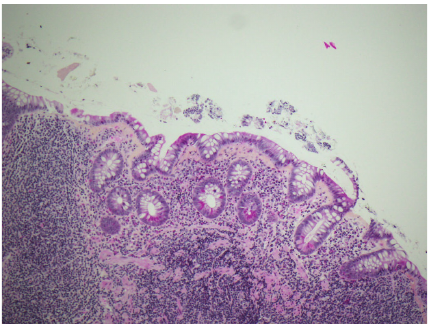
Figure 1: The ileal biopsies of the patient showed pathognomonic findings of collagenous sprue including villous atrophy with thick- ened collagen table (HPS, 10x).